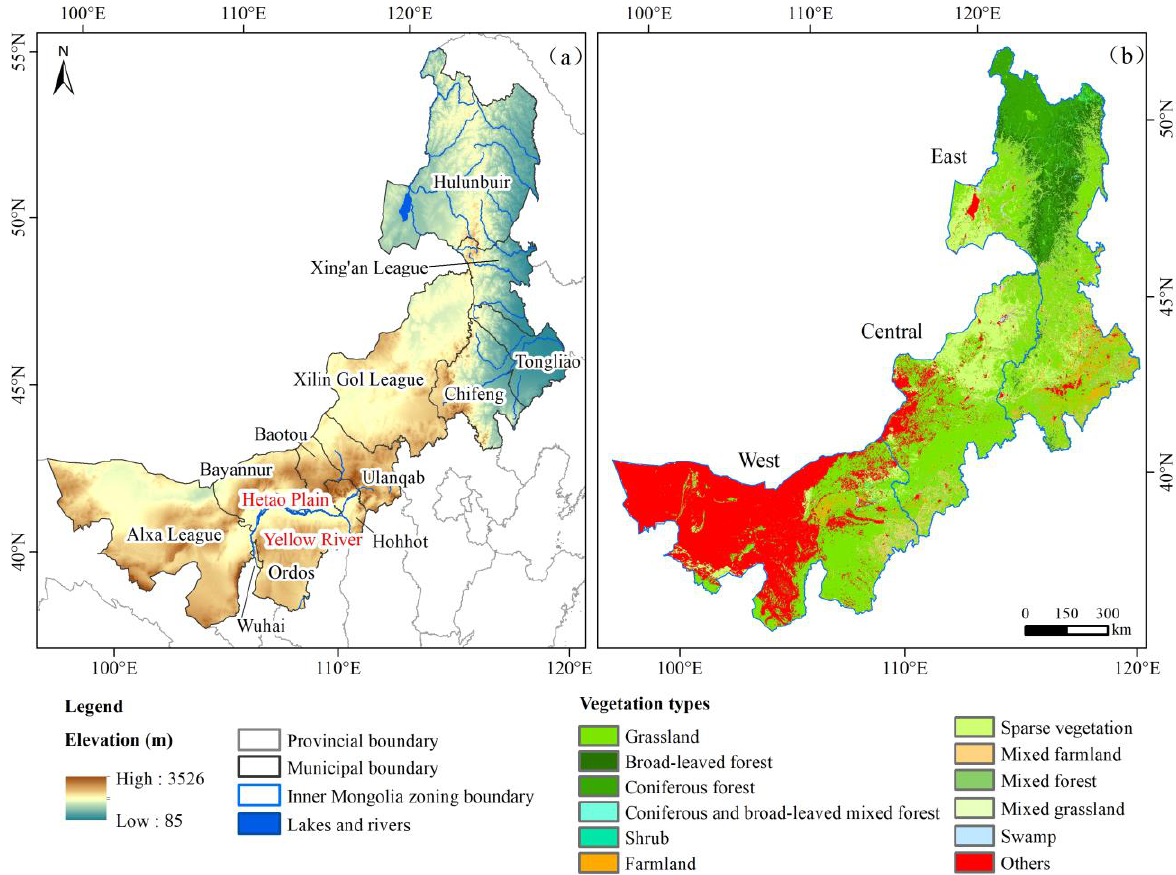
Figure 1. An overview of Inner Mongolia and vegetation type in 2019. ( a ) shows the geographic location, administrative division, elevation, and distribution of major rivers in Inner Mongolia. Dig- ital elevation model (DEM) data was downloaded from Google Earth Engine (https://earthen- gine.google.com/, accessed on 11 December 2021). The vector data of administrative boundaries, rivers, and lakes were from China ’ s 4 million basic geographic database. ( b ) shows the distribution of vegetation types in 2019 and the three parts according to the “ China Meteorological Geographical Division ” . The vegetation type data came from the European Space Agency ’ s global land cover da- taset (http://maps.elie.ucl.a-c.be.CCI/viewer, accessed on 11 December 2021). The eastern part is a